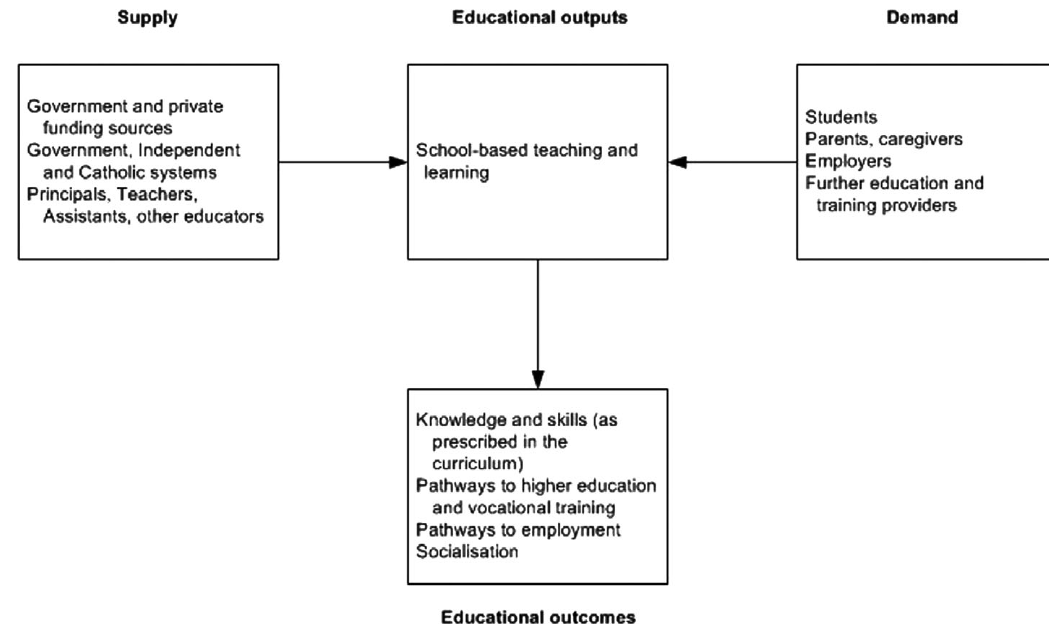
Simplified supply/demand/outcome schema for mainstream education (CRC-REP,